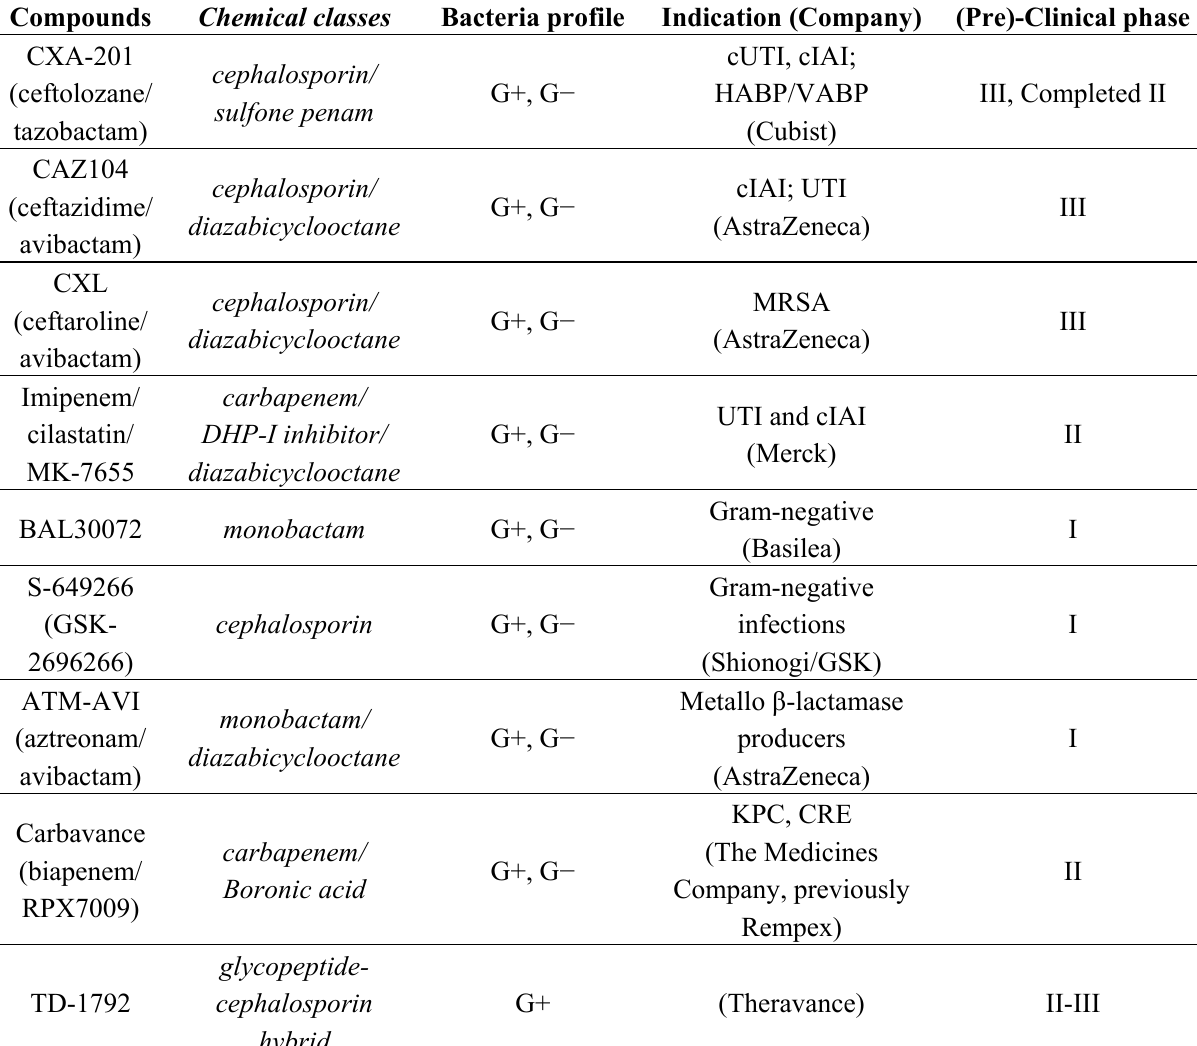
Table 2. β-Lactams, β-lactamase inhibitors, and β-lactams/β-lactamase inhibitor combinations in development